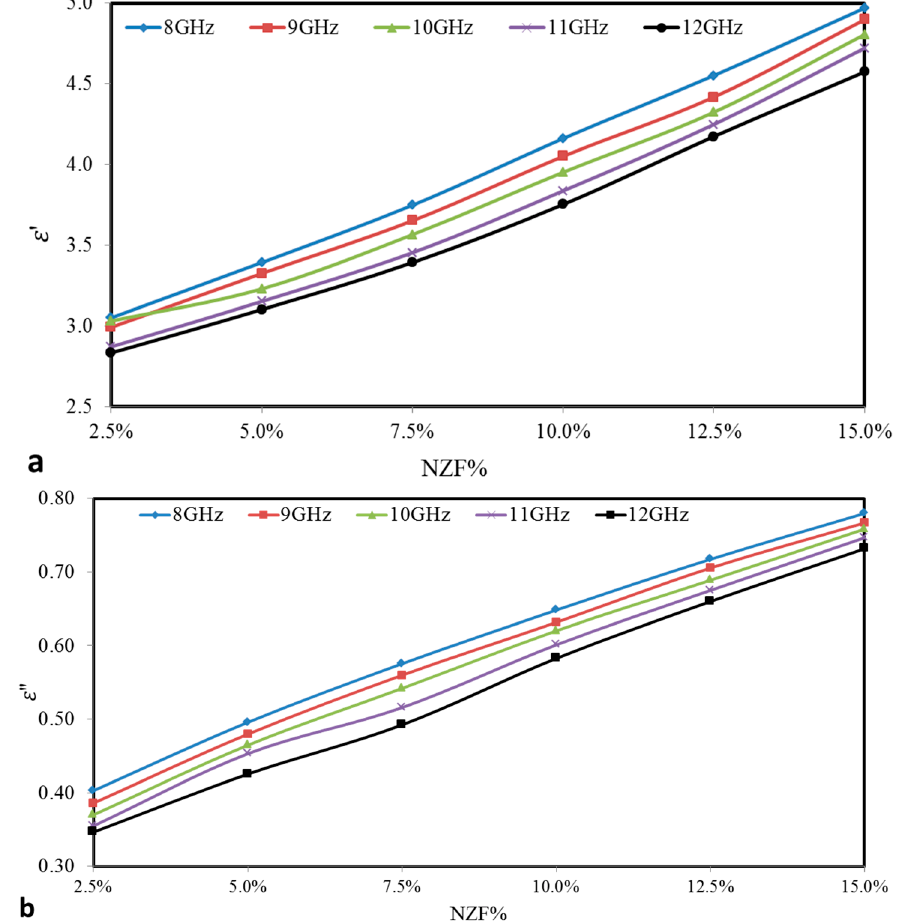
Figure 6. Variations of ( a ) Effective (relative) permittivity ( ε′ ) ( b ) Imaginary part of the relative permittivity ( ε″ ) with different NZF% for NZF + OPEFB + PCL composites.